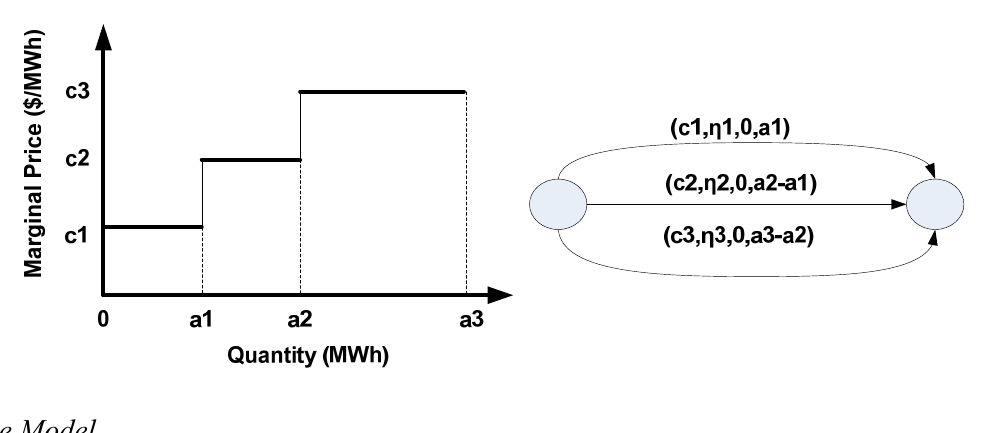
Figure 2. A generator marginal cost curve.